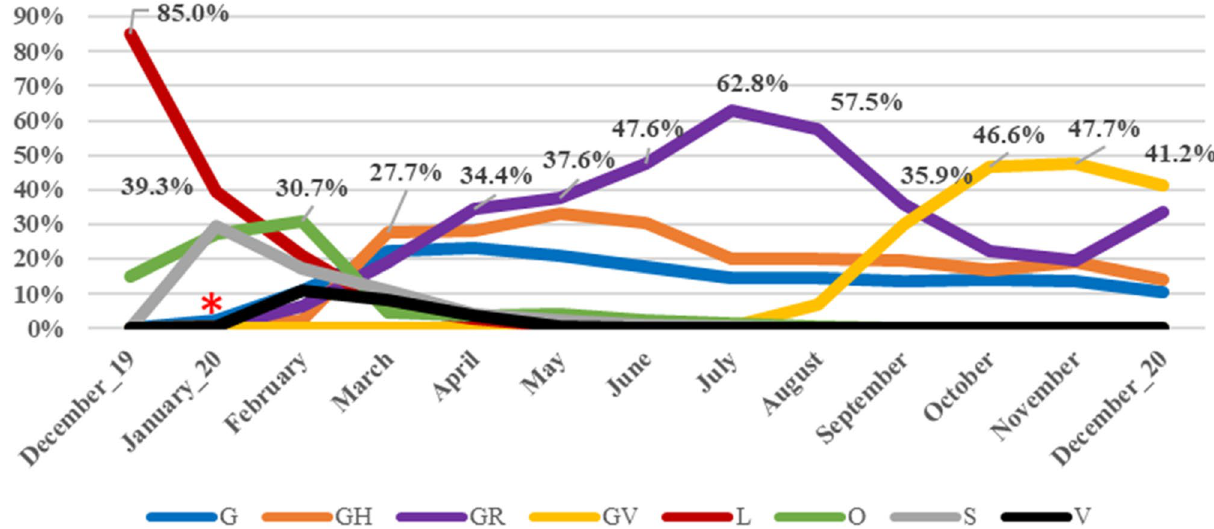
Figure 2. Global chronological distribution of SARS-CoV-2 clades in the period from December 2019 till December 2020. Percentages are used for labelling the predominant clade in each month. The emergence of D614G mutation is marked by a red asterisk.